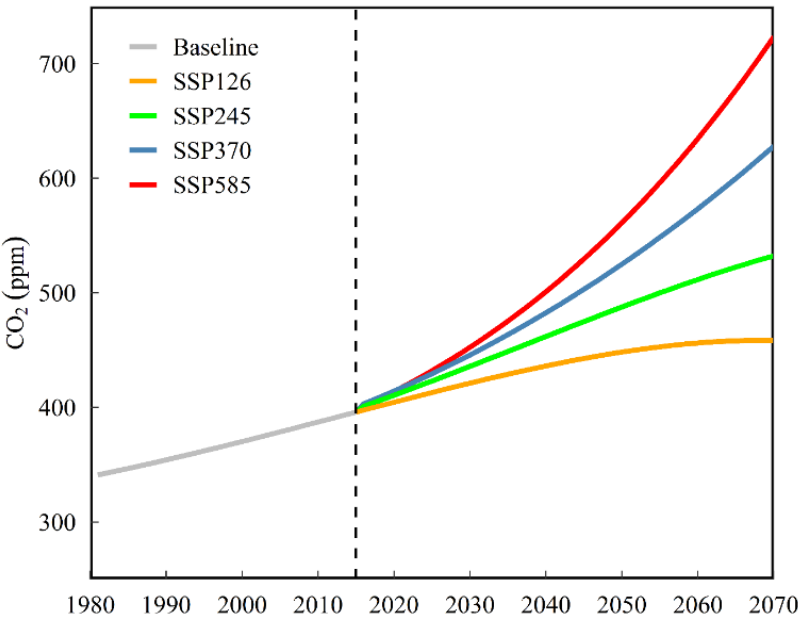
Figure 2. The atmosphere CO 2 concentration under different future climate scenarios.